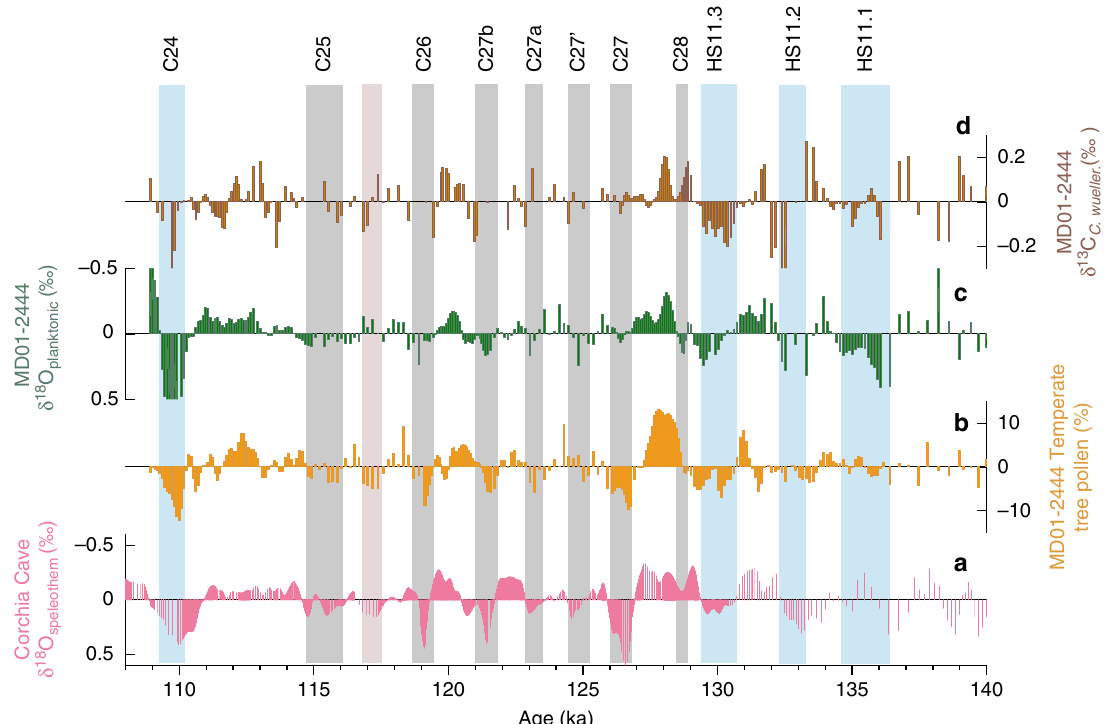
Fig. 4 Comparison of intra-interglacial aridity events and ocean changes. a Detrended and smoothed Corchia Cave stacked δ 18 O speleothem series. b Detrended and smoothed MD01-2444 temperate tree pollen. c Detrended and smoothed MD01-2444 δ 18 O planktonic . d Detrended and smoothed MD01- 2444 δ 13 C C. wueller . (see Methods). Records plotted on the Corchia Cave timescale. Light blue vertical bars indicate events HS11.1, HS11.2, HS11.3 and C24; grey bars denote interglacial arid events (de fi ned in Corchia Cave δ 18 O speleothem and MD01-2444 temperate tree pollen records) that show coupled pollen and δ 18 O planktonic changes and light pink bar denotes an aridity event associated with negative rather than positive δ 18 O planktonic values (see